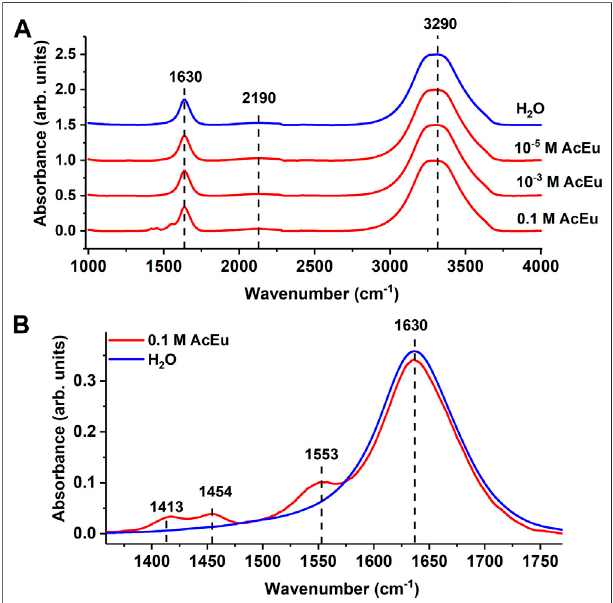
FIGURE 2 | (A) IR spectra of AcEu solutions of different concentrations (red) and water (blue). The spectra are shifted along the ordinate axis. (B) an enlarged section of the spectra in the 1360 – 1770 cm − 1 region. The spectra overlap each